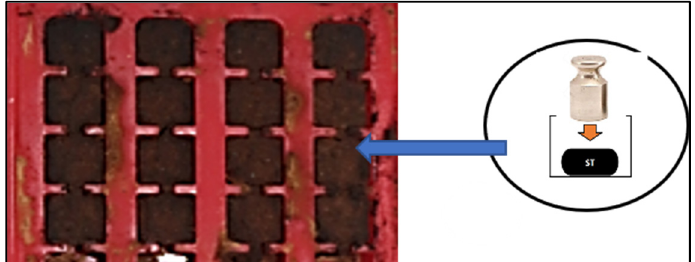
Figure 3. The specimens during force application on black smokeless